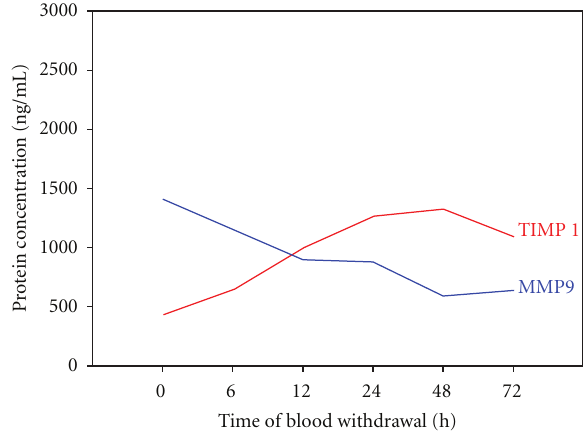
Figure 3: Significant inversely proportional concentration kinetics of MMP-9 and its specific inhibitor TIMP-1 during the observed posttraumatic time period of 72 h. The blue line indicates the connection of all measured time points concerning the significant decrease of MMP-9 serum concentration whereas the red one indicates the connection of all measured time points regarding the significant increase of TIMP-1 serum concentration.